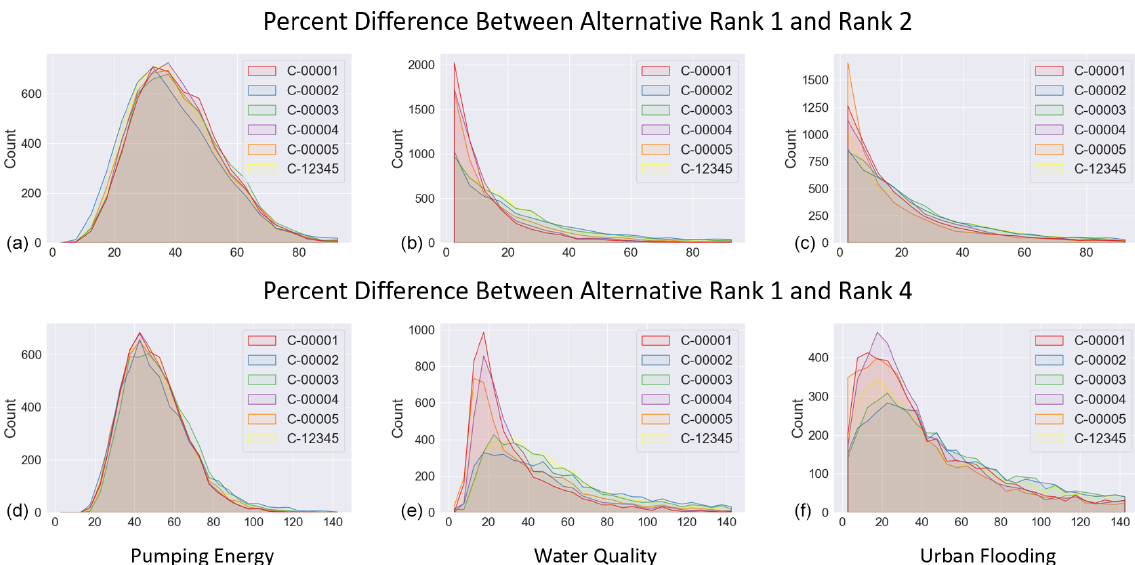
Figure 10. The difficulty of the decision represented by the relative performance of the alternatives within the samples evaluated for each objective (columns). Panels (a) – (c) show the distribution of the percent difference in each sample between the first and second ranked alternatives within the cluster datasets. Panels (d) – (f) show the distribution of the percent difference in each sample between the first and fourth ranked alternatives within the cluster